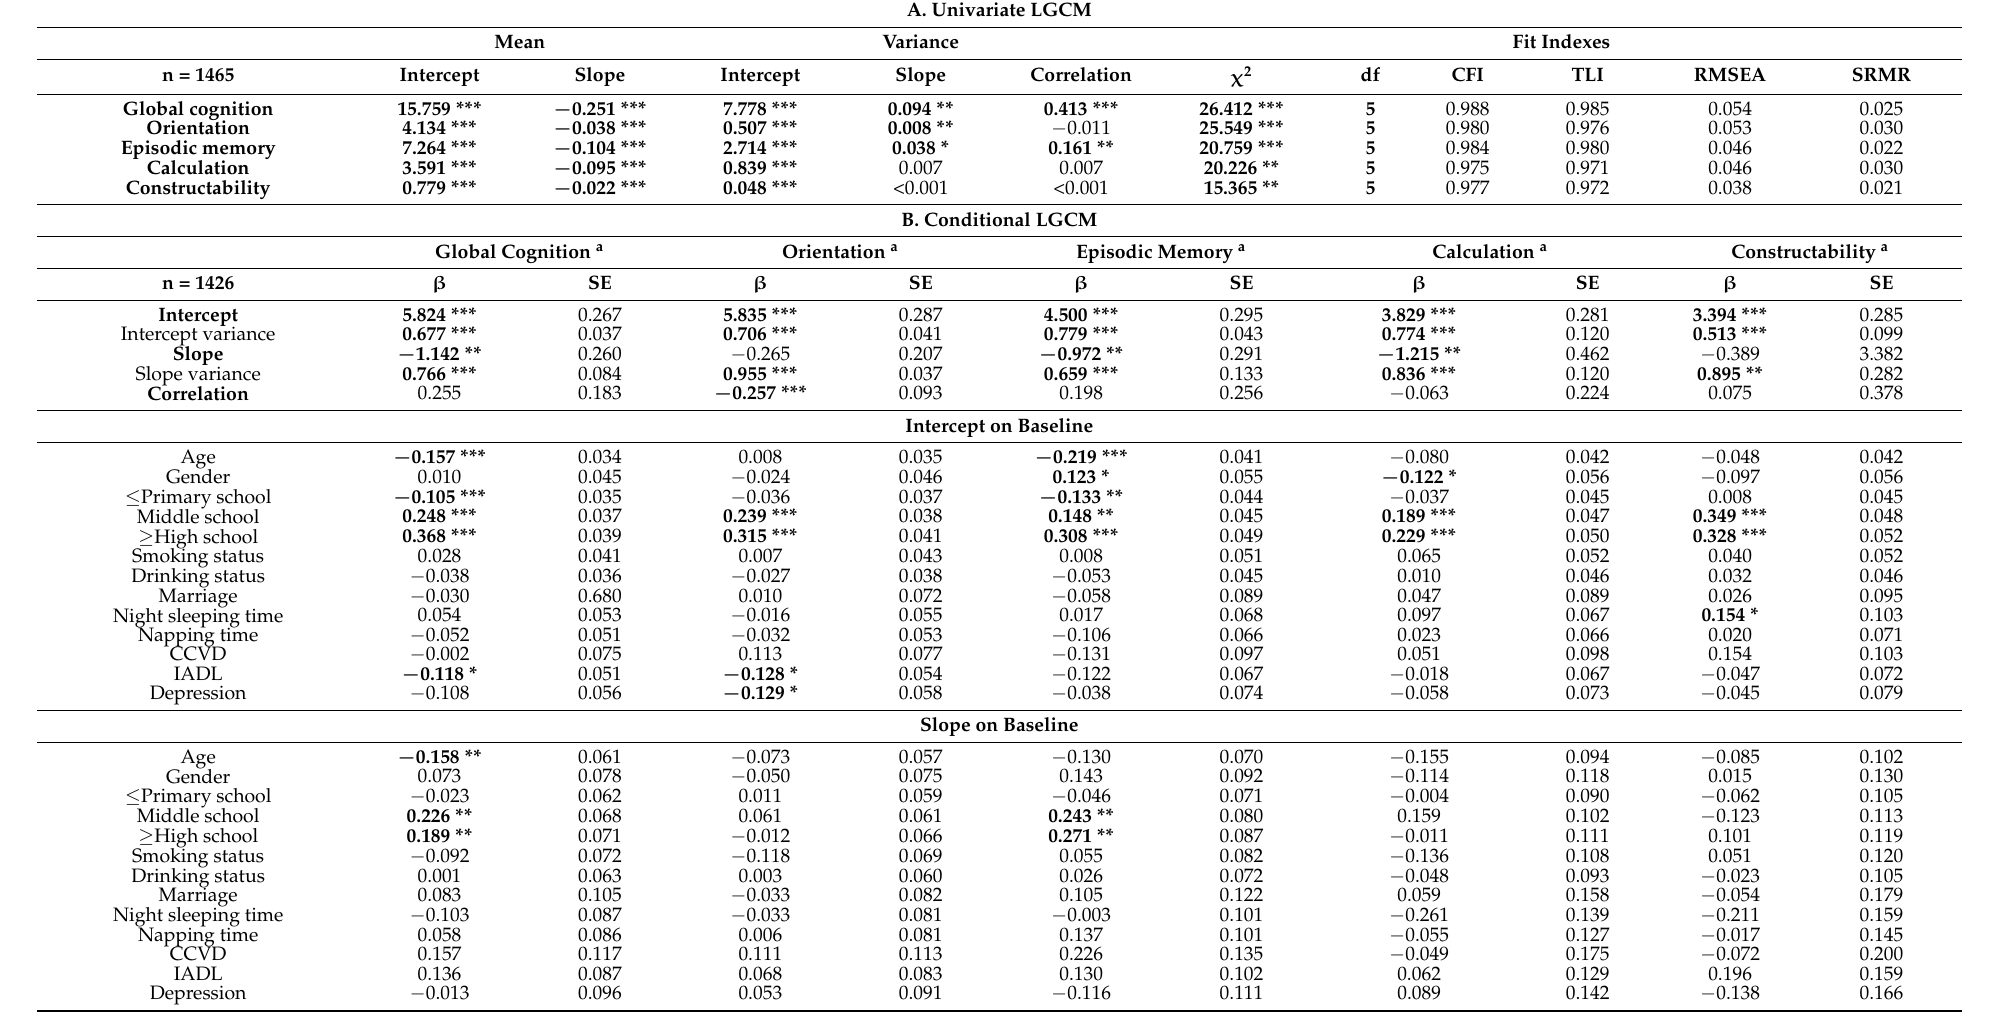
Table 2. Results of the univariate and conditional linear Latent Growth Curve Models